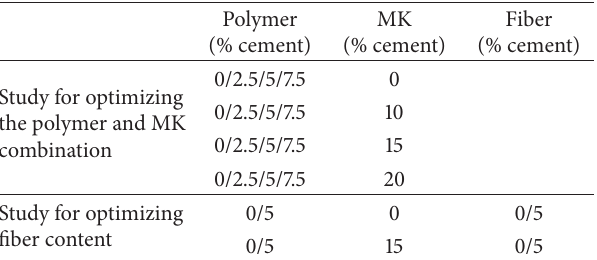
Table 6: The mixtures proportion used in this study.